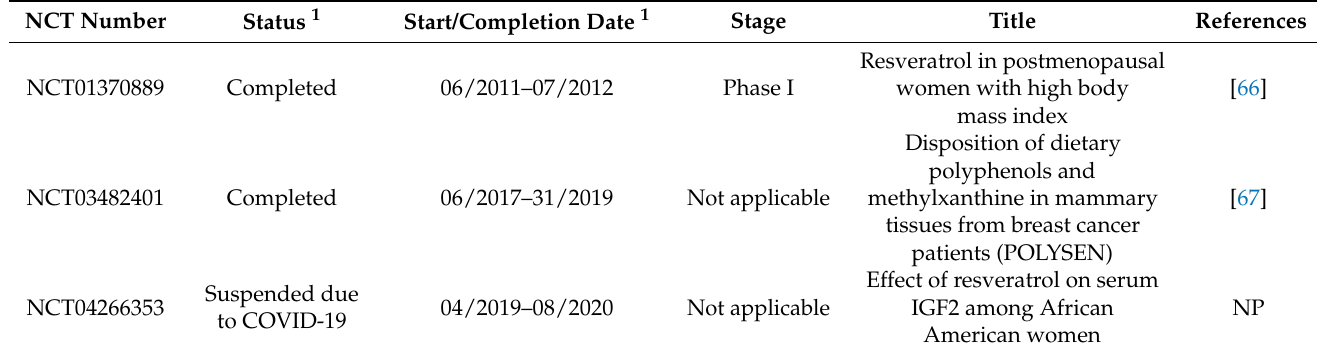
Table 2. Clinical trials with resveratrol in breast